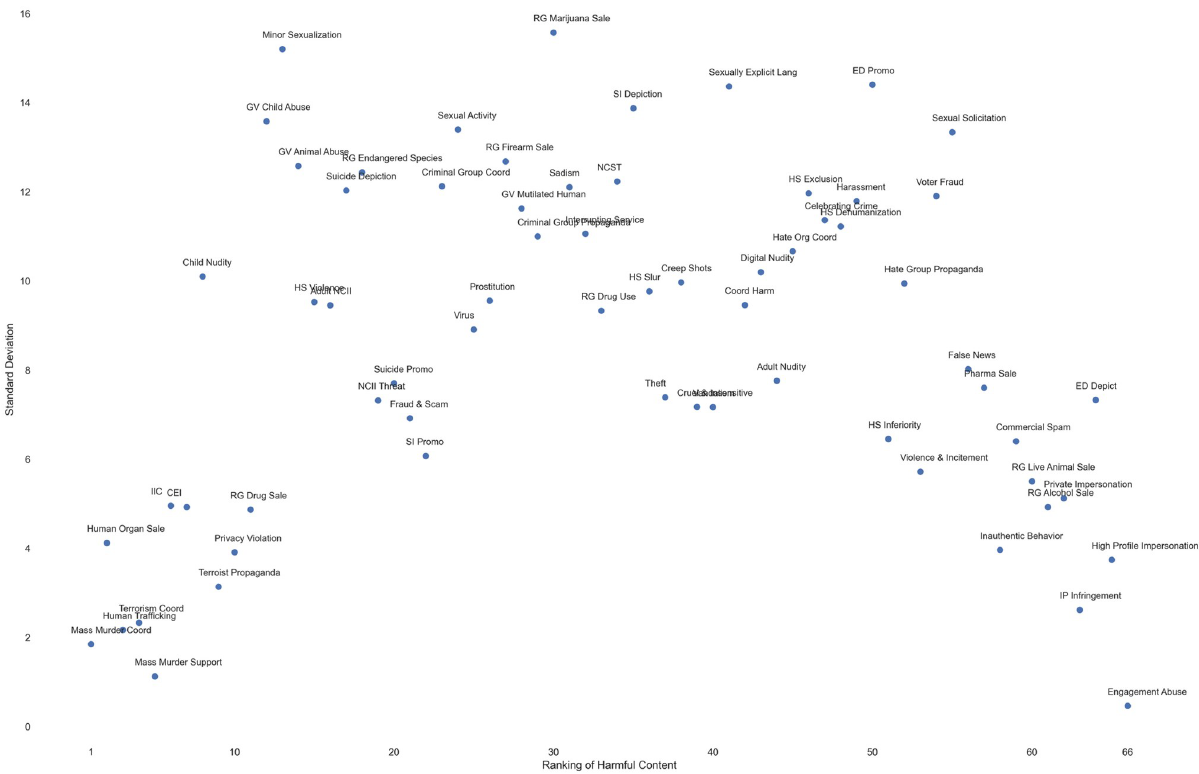
Fig 5. Harmful content’s standard deviation vs. sample-wide